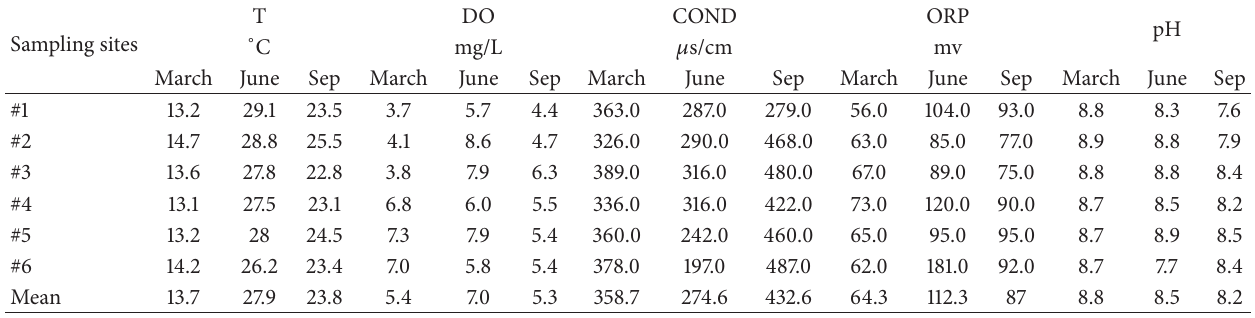
Table 1: Environmental parameters measured in Changdang Lake during the study period.